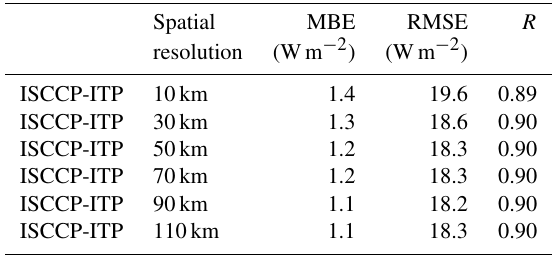
Table 5. Effect of spatial resolution (from 10 to 110km) on accu- racy of our estimated daily PAR product (ISCCP-ITP) compared to observations at the 38 CERN